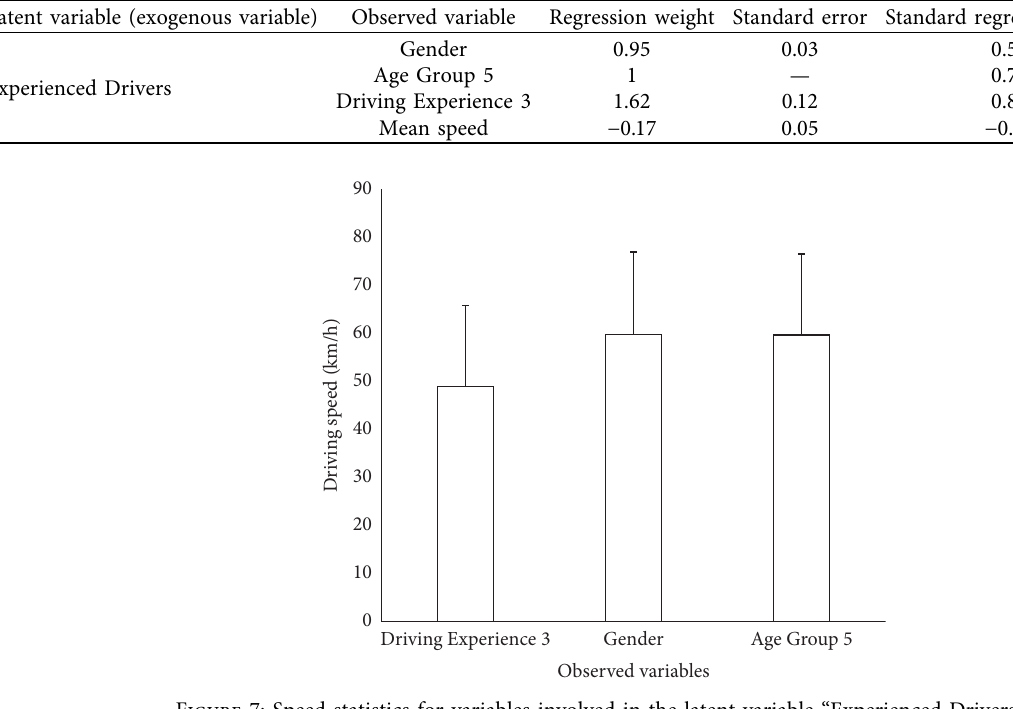
Table 9: SEM results for the latent variable “Experienced Drivers.”